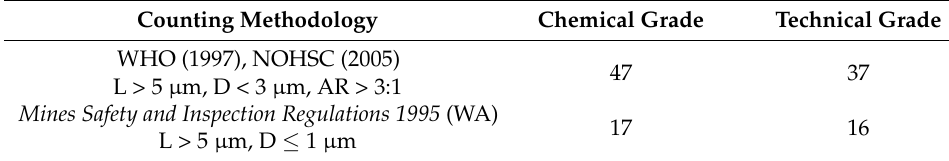
Table 2. Counting criteria outcomes.